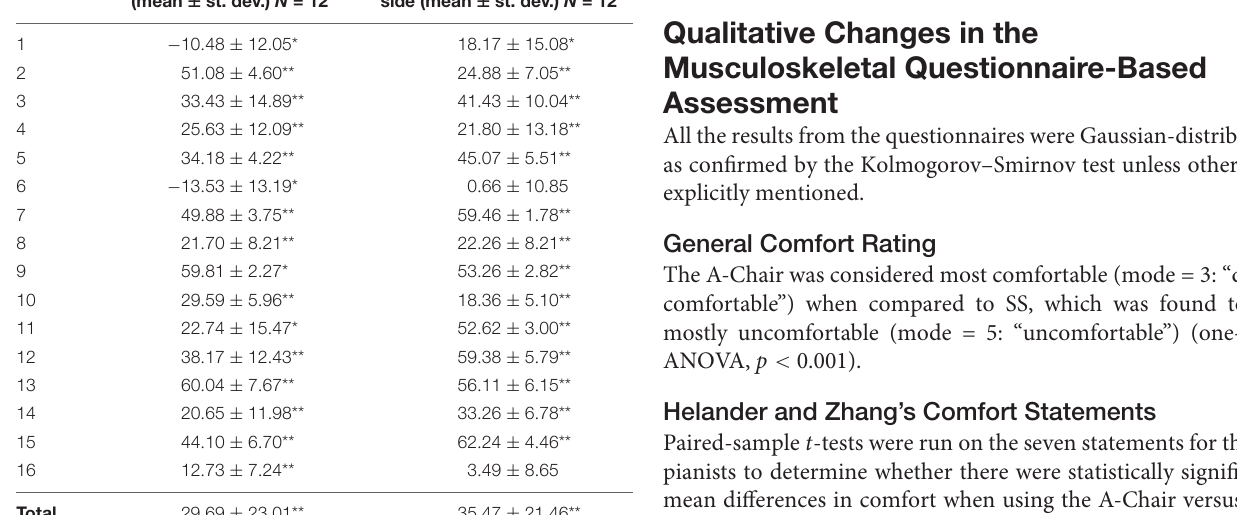
TABLE 2 | Mean percentage change of the RMS ROA for each subject sitting on the SS and A-Chair. Subject Mean RMS ROA % change Mean RMS ROA % change due to chair type on left side due to chair type on right (mean ± st. dev.) N = 12 side (mean ± st. dev.) N =